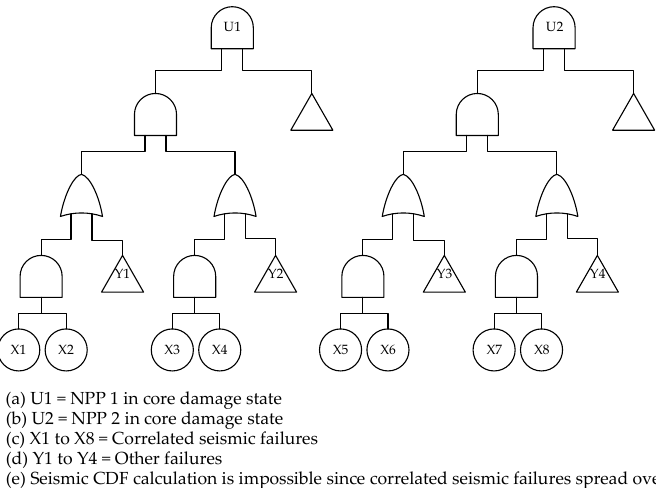
Figure 1. SUCDF fault tree with correlated seismic failures (Model A).